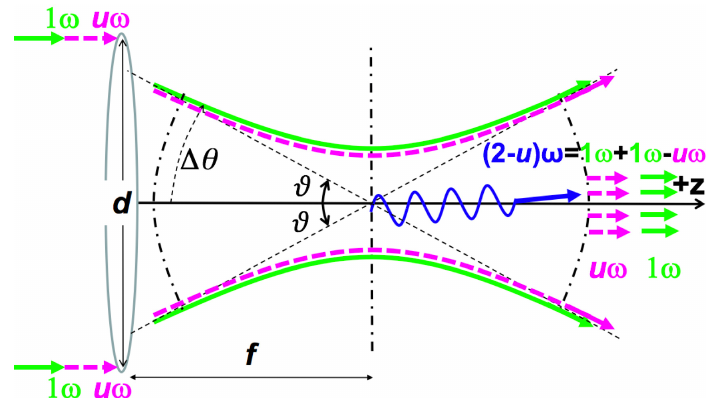
Figure 1 . Concept of stimulated resonant photon-photon scattering in a quasi-parallel collision system (QPS) by focusing two-color laser fields in a vacuum. This figure is quoted from [28] with a slight modification. A coherent field with energy ω (solid green line) is combined with a different-color coherent field with energy uω (0 < u < 1) (dashed red line). The combined fields are focused by a lens element in a vacuum. Emission of signal photons with energy (2 − u ) ω (blue wavy line) is stimulated as a result of energy-momentum conservation in the scattering process ω + ω → φ/σ → (2 − u ) ω + uω via a resonance state φ/σ . Given the focusing parameters of beam diameter d and focal length f , the incident angle ϑ is expected to vary over 0 < ϑ ≤ ∆ θ . This unavoidable ambiguity of the wave vectors of the incident light waves provides a wide window for accessing different center-of-mass system energies at a given point in